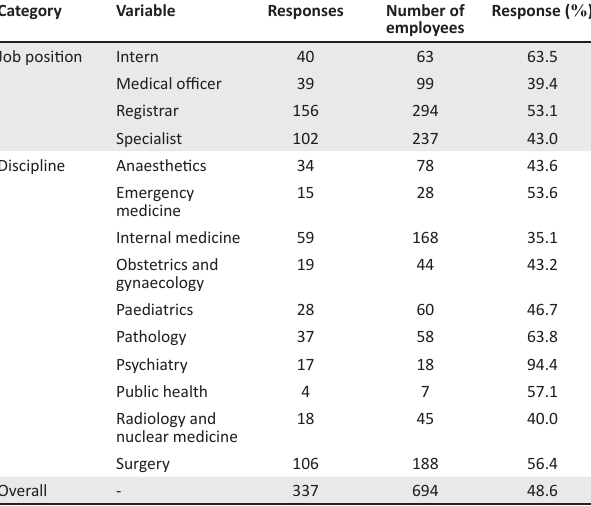
TABLE 1: Response rate according to job position and discipline. Category